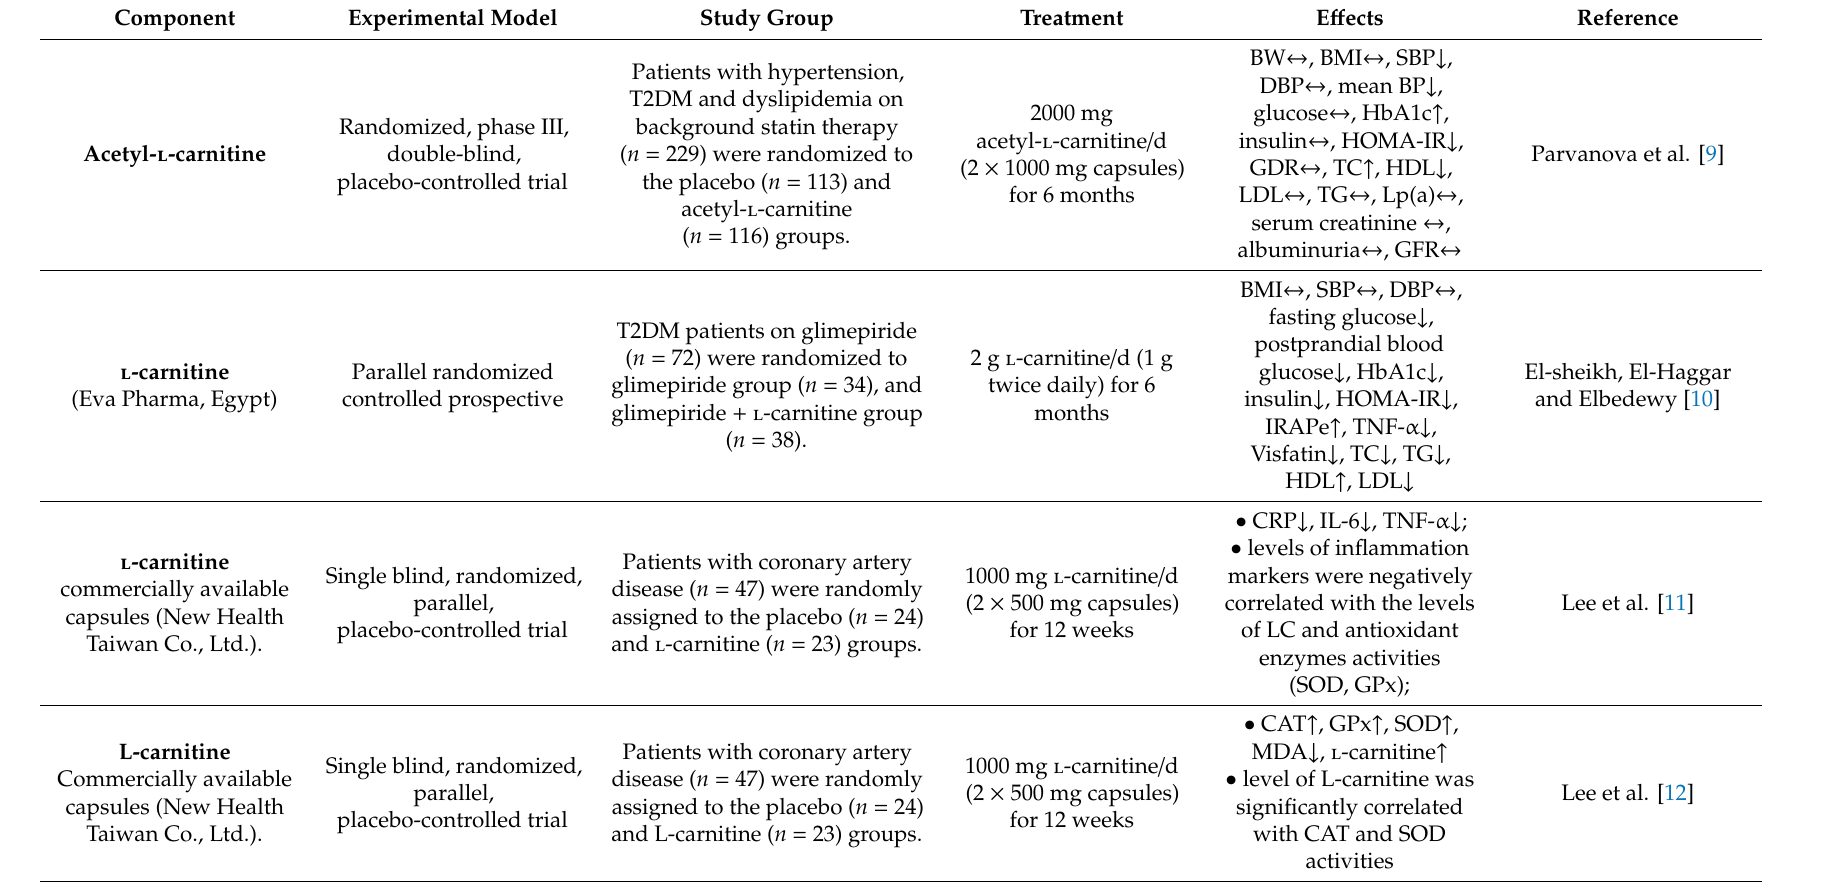
Table 1. E ff ects of meat components intake–in vivo studies performed on